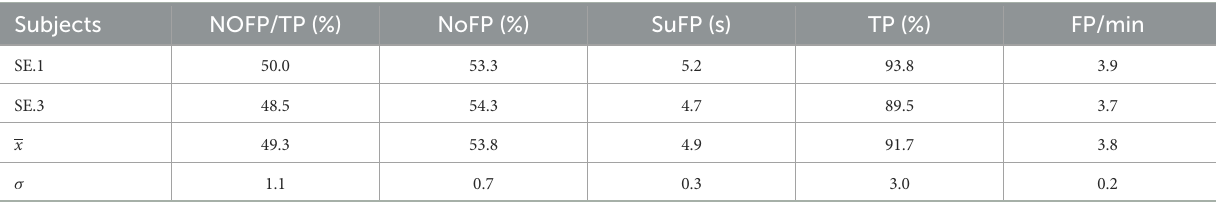
TABLE 7 Performance of the BMI working in close-loop control of the exoskeleton.